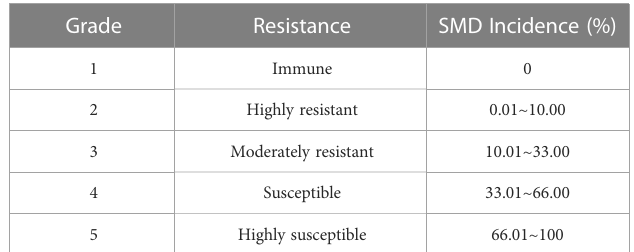
TABLE 2 Resistance grading based on SMD incidence.